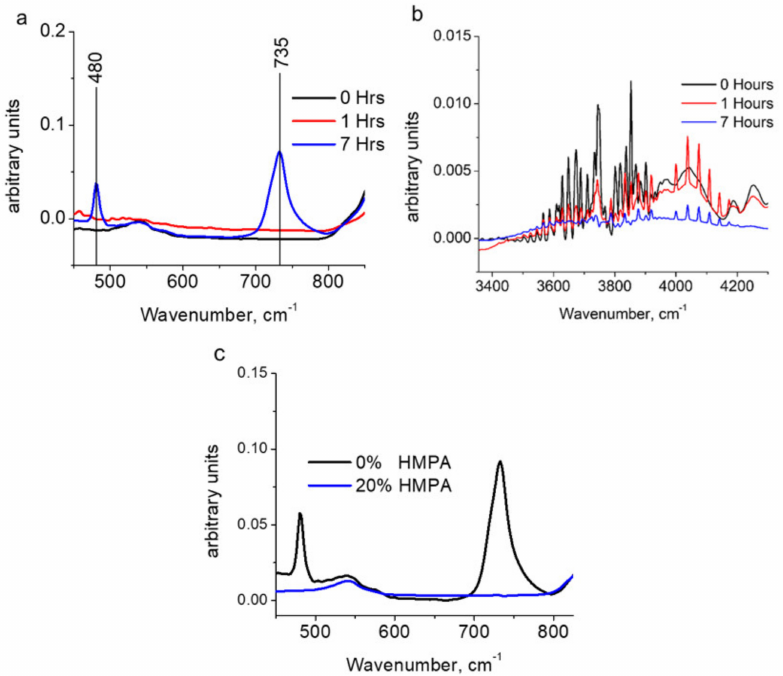
Figure 7. FTIR spectra of gas phase of 1 M NaPF 6 in DME at 85 ◦ C. Top spectra are without HMPA, with ( a ) highlighting the HF region, ( b ) highlighting the PF 5 region during degradation, and ( c ) comparing the effect of HMPA addition after 7 h. NaPF 6 will degrade into PF 5 and HMPA suppresses PF 5 formation in the gas